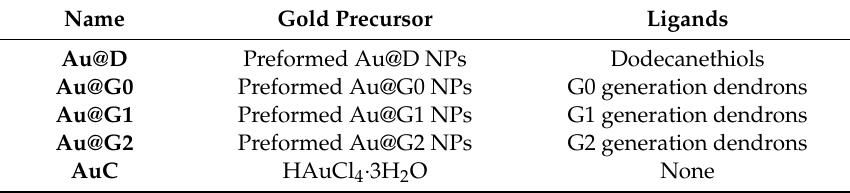
Table 1. Nomenclature of the gold